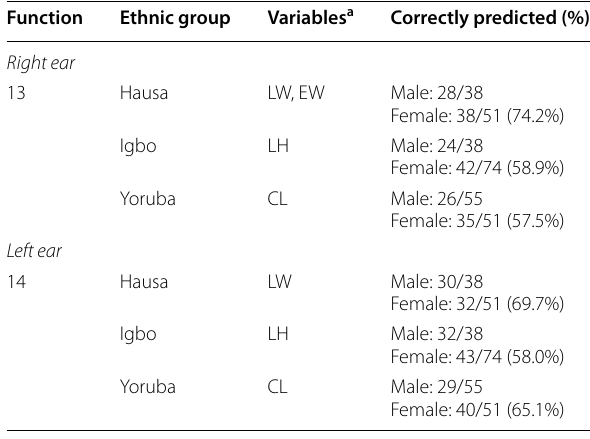
Table 11 Prediction accuracies for direct and stepwise discriminant